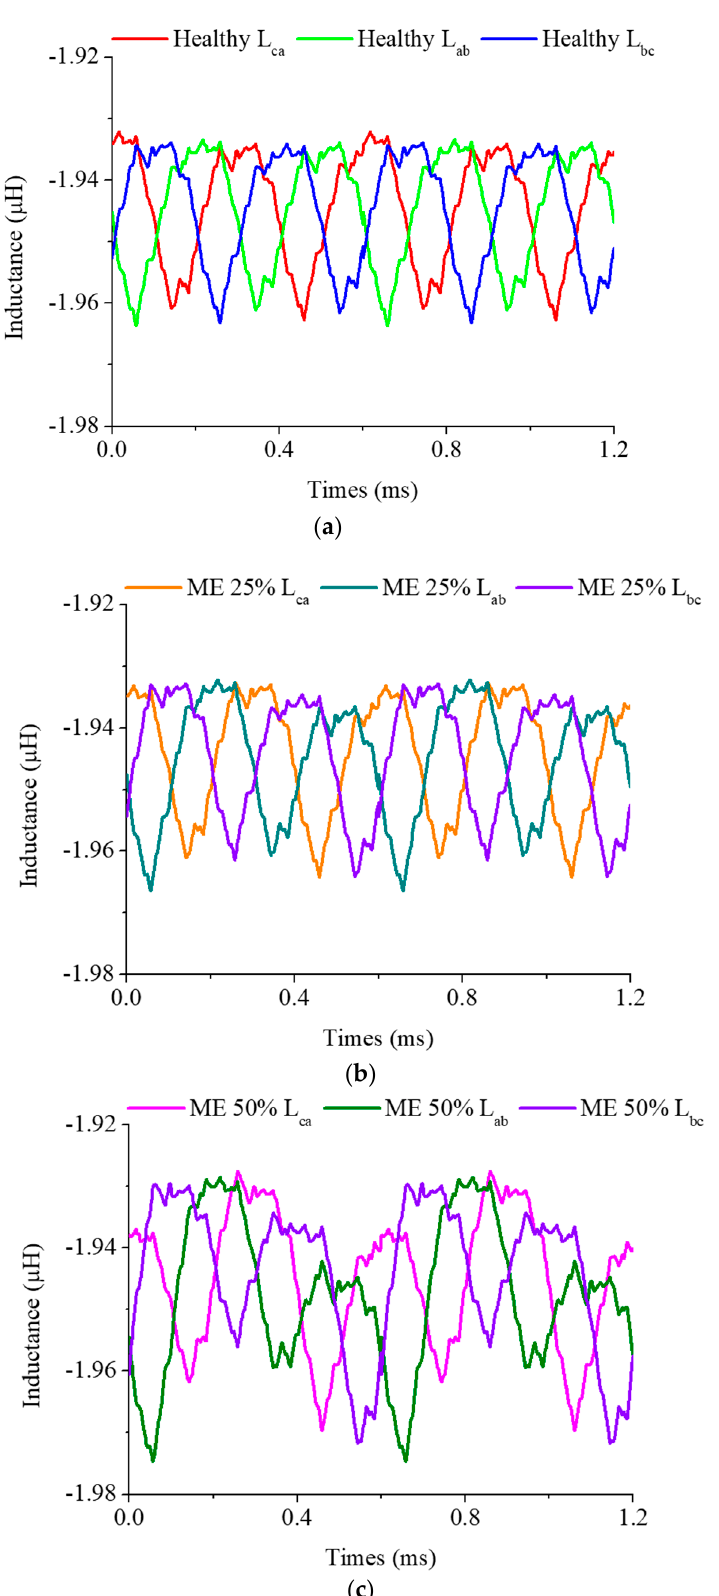
Figure 6. Line inductance according to the amount of mixed eccentricity: ( a ) Healthy condition, ( b ) Mixed eccentricity 25%, and ( c ) Mixed eccentricity 50%. Table 5. Line-to-line inductance (absolute value) according to mixed eccentricity.